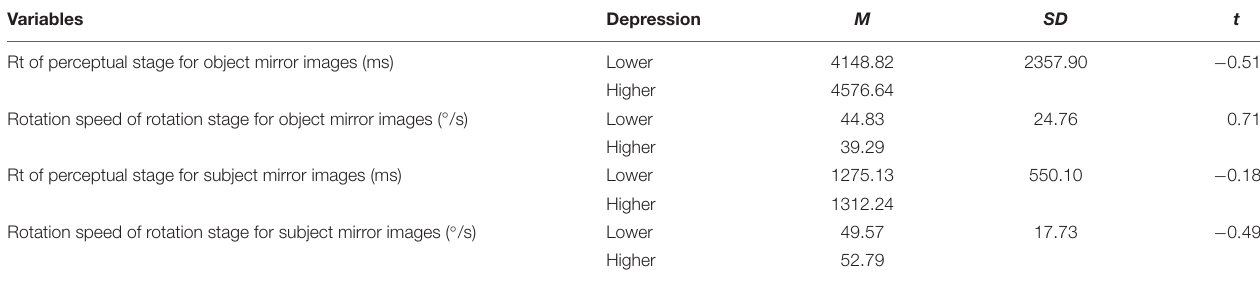
TABLE 2 | The comparison between two groups in reaction time and rotation speed. Variables